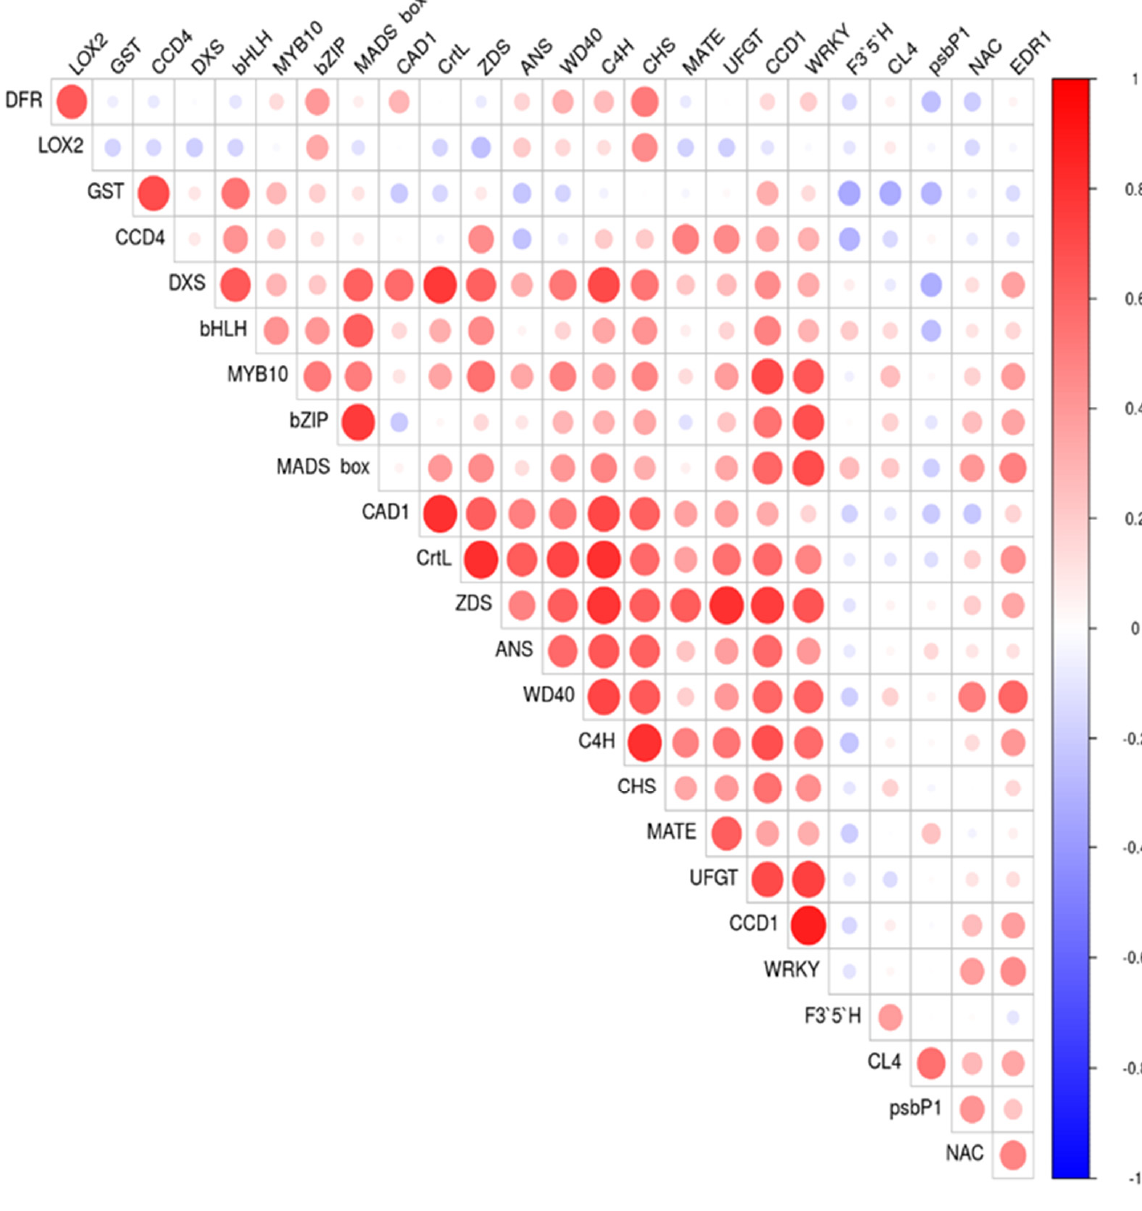
Figure 9. Pearson correlation plot for the relative gene expression evaluated by using RT-qPCR of genes involved in anthocyanins and carotenoids biosynthesis and ripening process progression in the nine cultivars ‘Bergeron’, ‘Cebasred’, ‘Currot’, ‘Dorada’, ‘Estrella’, ‘Goldrich’, ‘Moniquí’, ‘Valorange’ and ‘Z108-38 ′ at three ripening stages green fruit, during color change and at physiological ripening. The assayed genes included DFR, LOX2, GST, CCD4, DXS, bHLH, MYB10, bZIP, MADS-box, CAD1, CrtL, ZDS, ANS, WD40, C4H, CHS, MATE, UFGT, CCD1, WRKY, F3 ′ 5 ′ H, CL4, psbP1, NAC and EDR1.